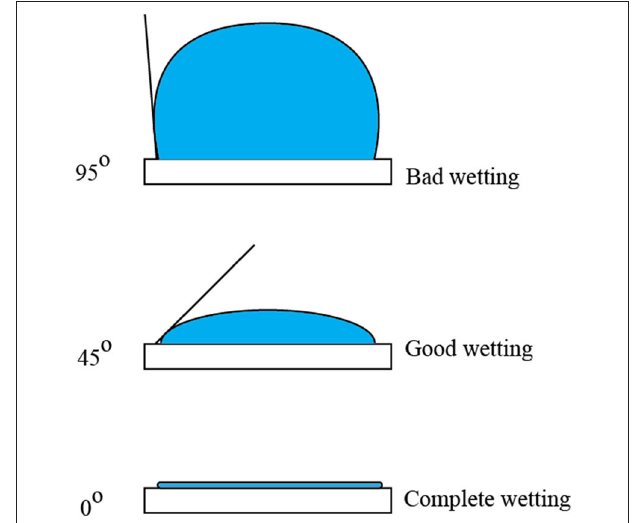
FIGURE 3 | Evaluate wetting properties of substances on treated